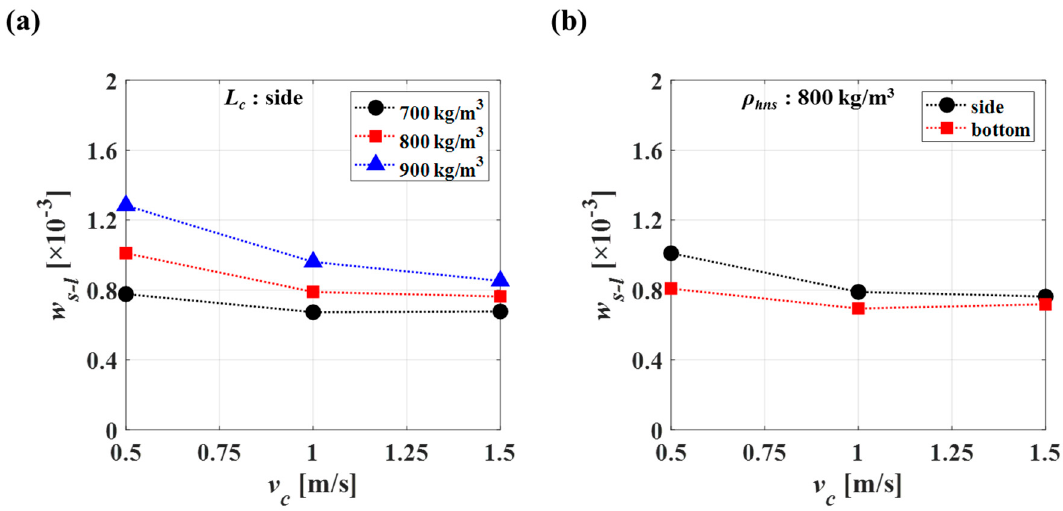
Figure 7. Predicted averaged mass fraction at sea-level of the HNS according to ( a ) HNS density and ( b ) crack location.